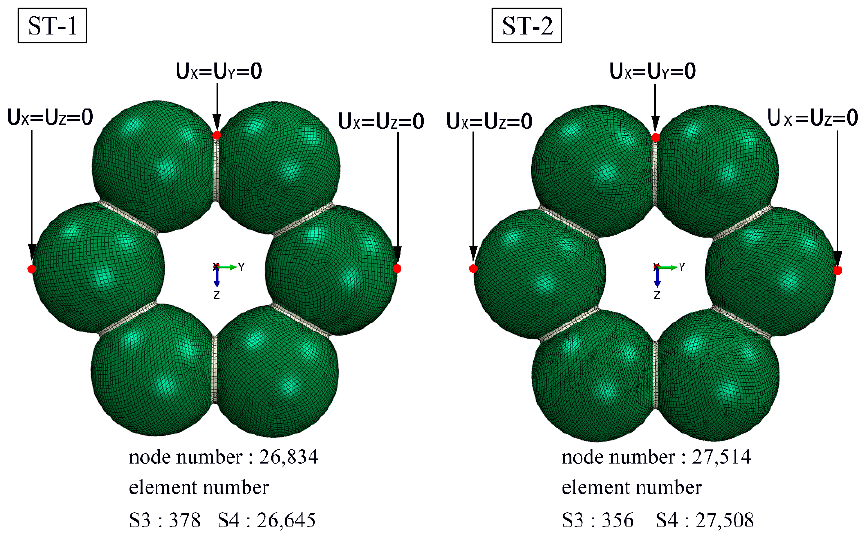
Figure 8. Finite-element models of sphere-segmented toroidal shells and relevant information.